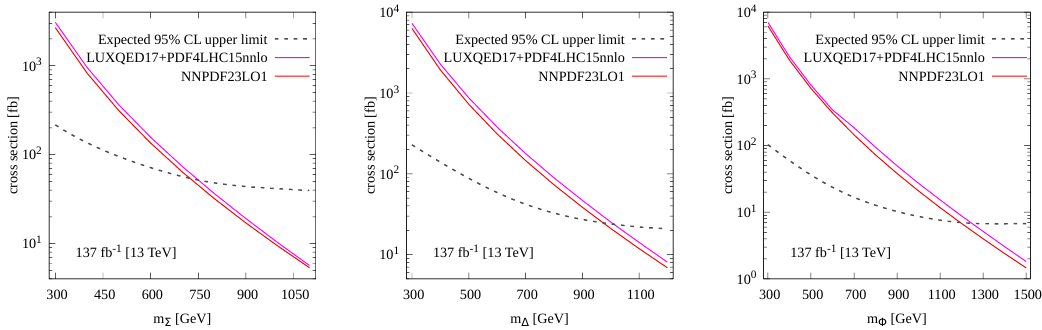
Figure 11 . Dashed line: 95% CL upper limit on the total production cross section of triplet (left most panel), quadruplet (middle panel), quintuplet (right most panel) fermions. Solid line: model prediction for total production cross section of the exotics of a given multiplet. See text for details.